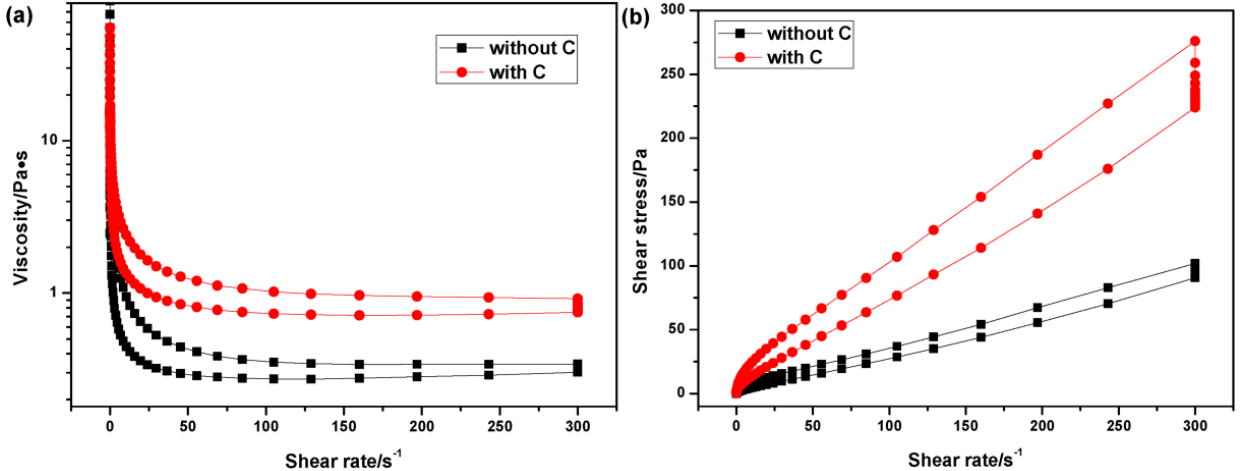
Figure 6. Rheological properties of 40 vol % ZSB and ZrB suspensions (pH 3).